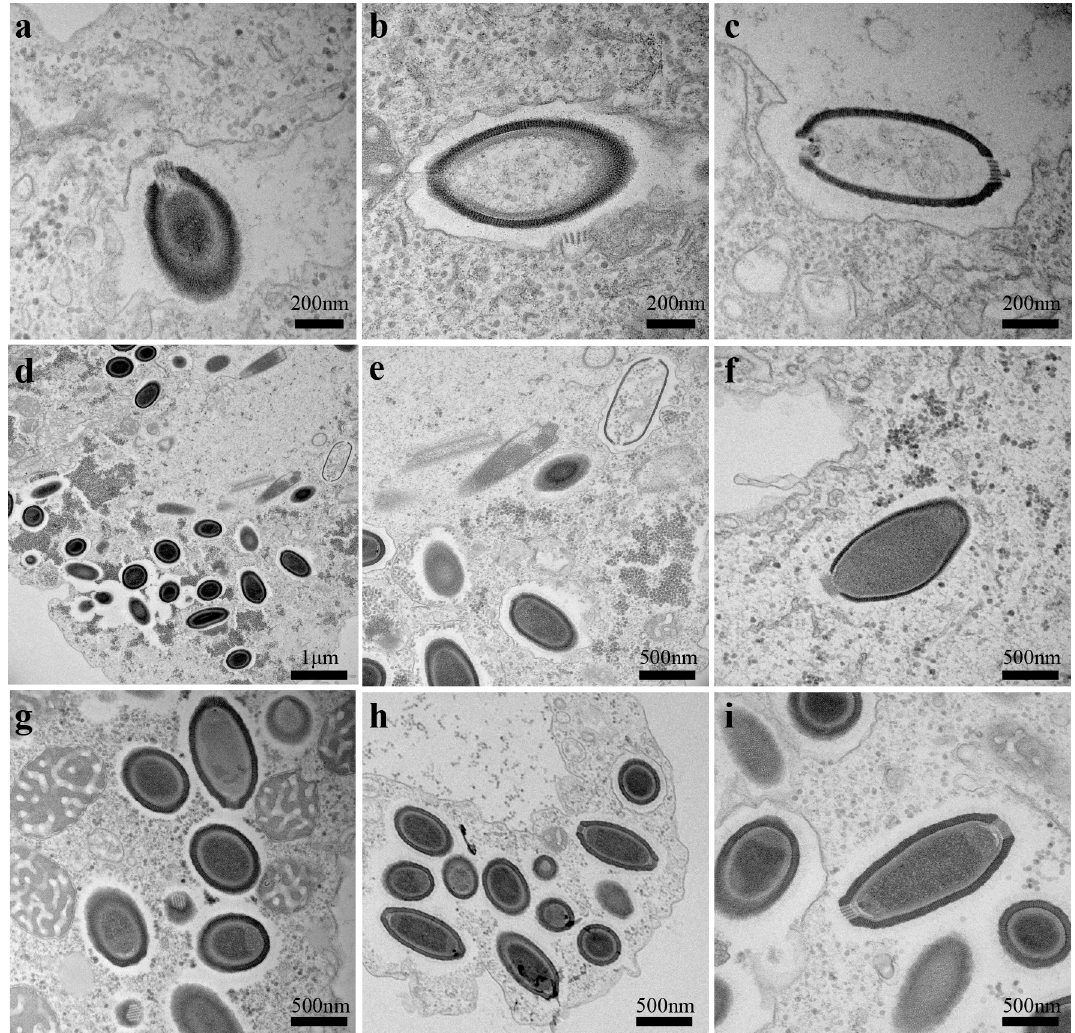
Figure 1. Ultrathin electron microscopy imaging of the Cedratvirus replication cycle in Acanthamoeba castellanii . ( a ) Neo ‐ phagocystis particle in vacuole; ( b ) Channel formation in first step of infection; ( c ) Empty particle 2 hours post ‐ infection (hpi) into a vacuole; ( d – h ) Various stages of concomitant Cedratvirus between 6 and 8 hpi in the cytoplasm of the amoeba; ( i ) Typical mature particle with the two corks. Table 1. Overview of Cedratvirus and Pithovirus properties.